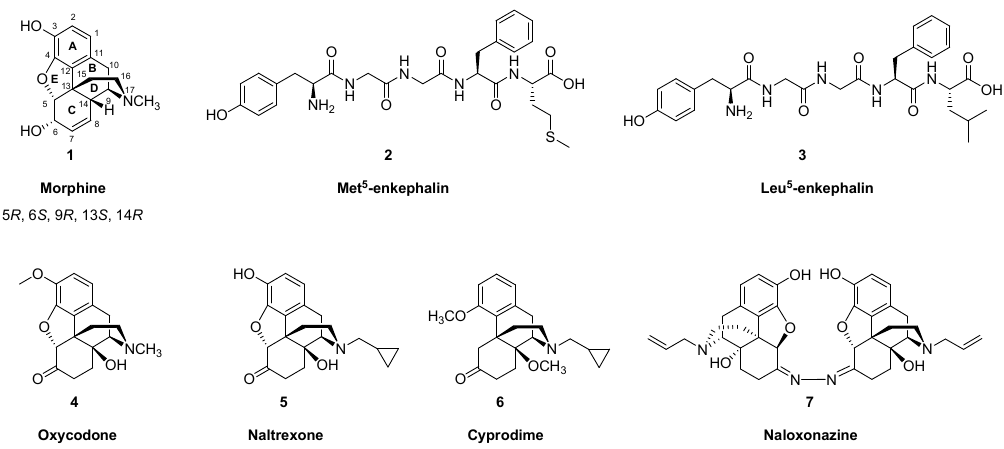
Figure 1. Chemical structures of endogenous opioid peptides and selected opioid receptor ligands.